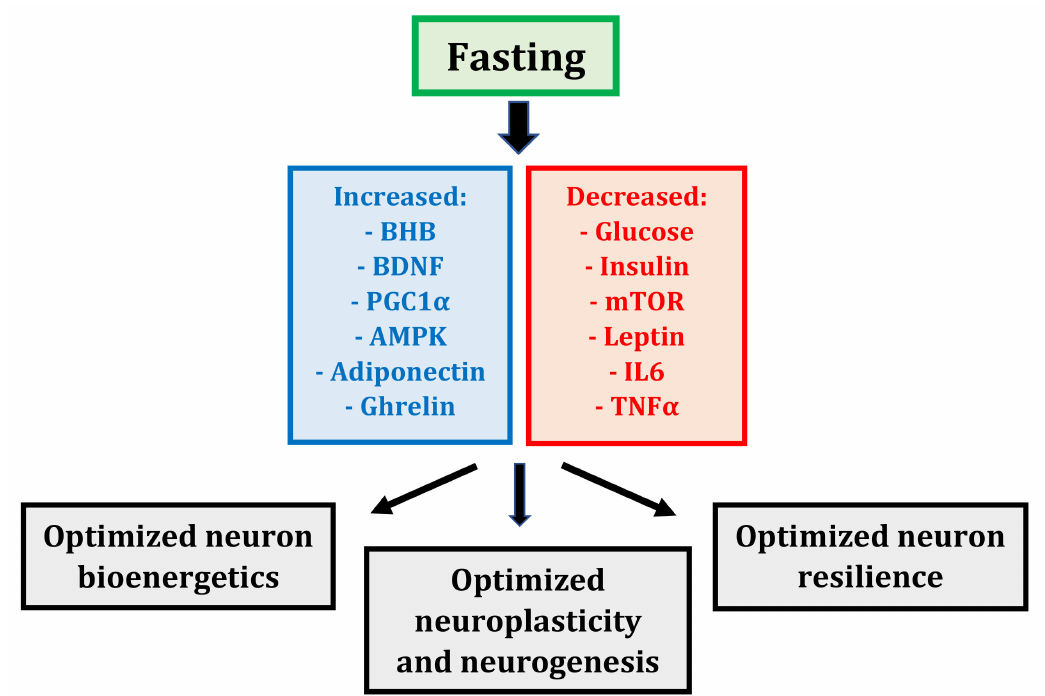
Figure 1. Fasting-induced metabolic and transcriptional mechanisms and their e ff ects on neurons (BHB—beta-hydroxybutyrate; BDNF—brain-derived neurotrophic factor; PGC1 α —peroxisome proliferator-activated receptor γ coactivator 1 α